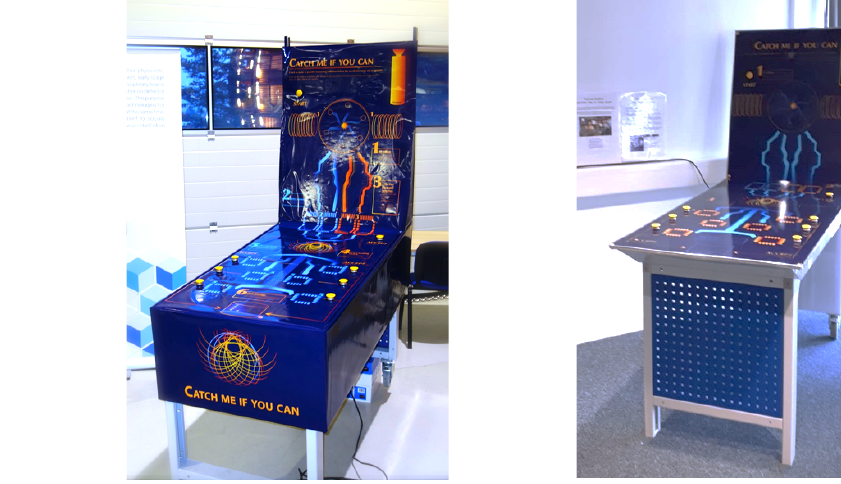
Fig. 1. The final working prototype of the CMS DAQ pinball machine in Nov 2016.